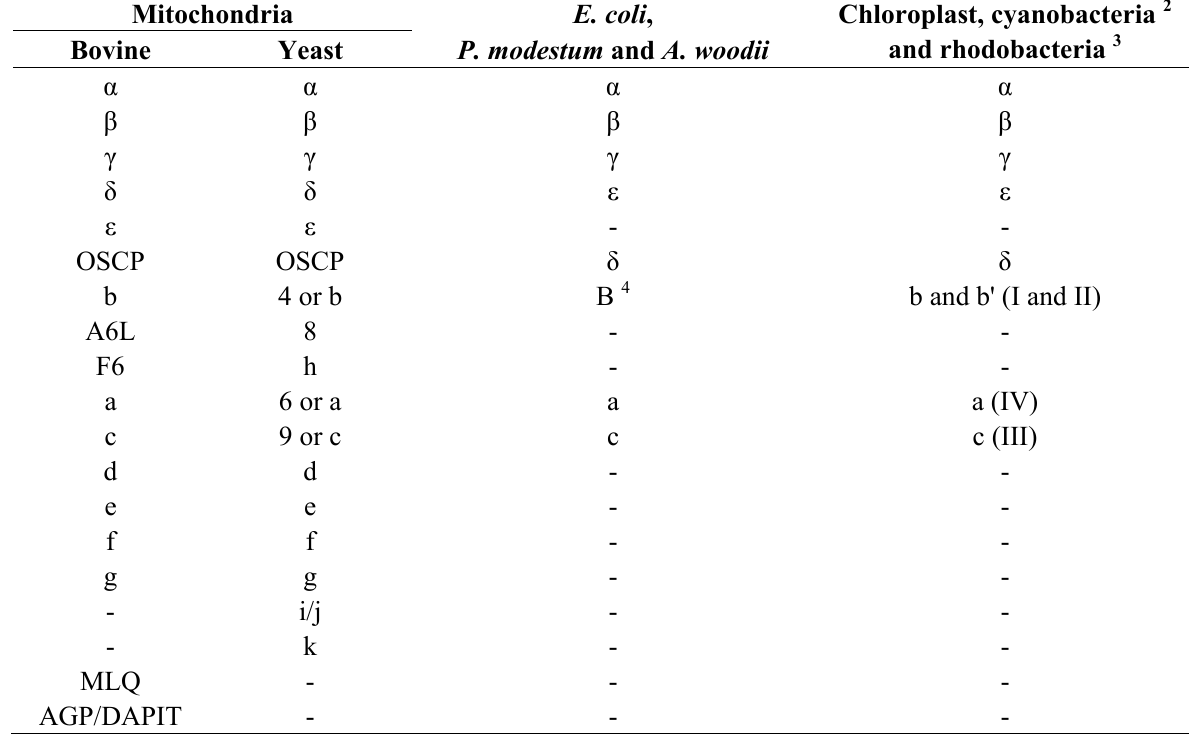
Table 1. Equivalence of subunits of ATP synthase from different sources 1